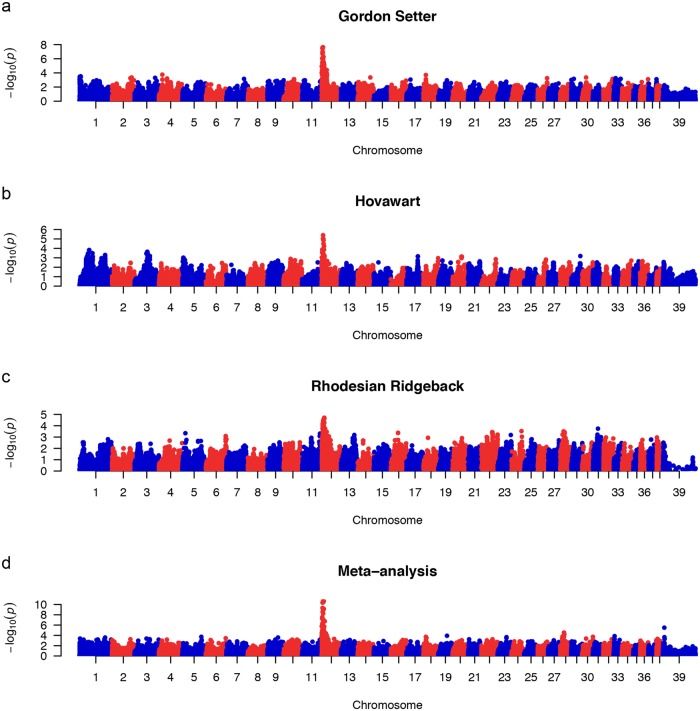
Manhattan plots showing a common peak on CFA12 in (a) GS praw = 2.4x10-8, (b) HV praw = 4.2x10-6, (c) RR praw = 2.0x10-5 and (d) multi-breed meta-analysis praw = 2.1x10-11.